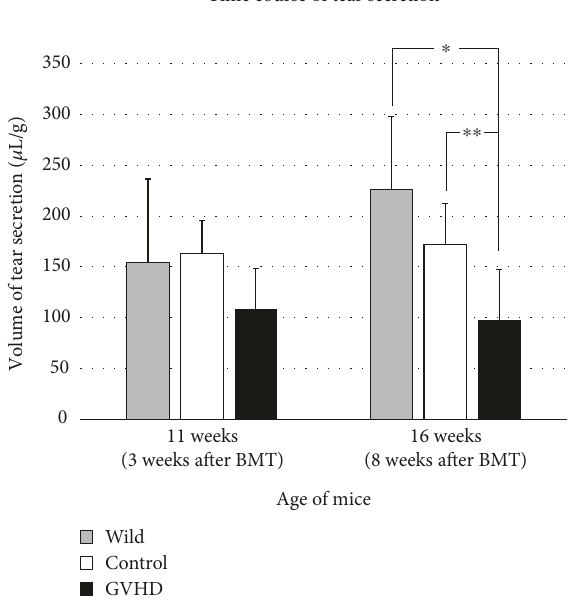
Figure 4: Comparison of tear secretion in wild-type, syngeneic control, and GVHD-a ff ected mice. The vertical axis shows the volume of secreted tears. The volume of tear secretion is adjusted for weight of each lacrimal gland ( μ L/g). Tear secretion in the wild-type (gray bars), syngeneic control (white bars), and GVHD-a ff ected mice (black bars) at the age of 11 (3 weeks after bone marrow transplantation (BMT) for the syngeneic control and GVHD-a ff ected mice) and 16 weeks (8 weeks after BMT for the syngeneic control and GVHD-a ff ected mice). n = 2 – 5 . Bar=mean ± SD. ∗ p = 0 011 , ∗∗ p = 0 073 . The experiments were performed three times.